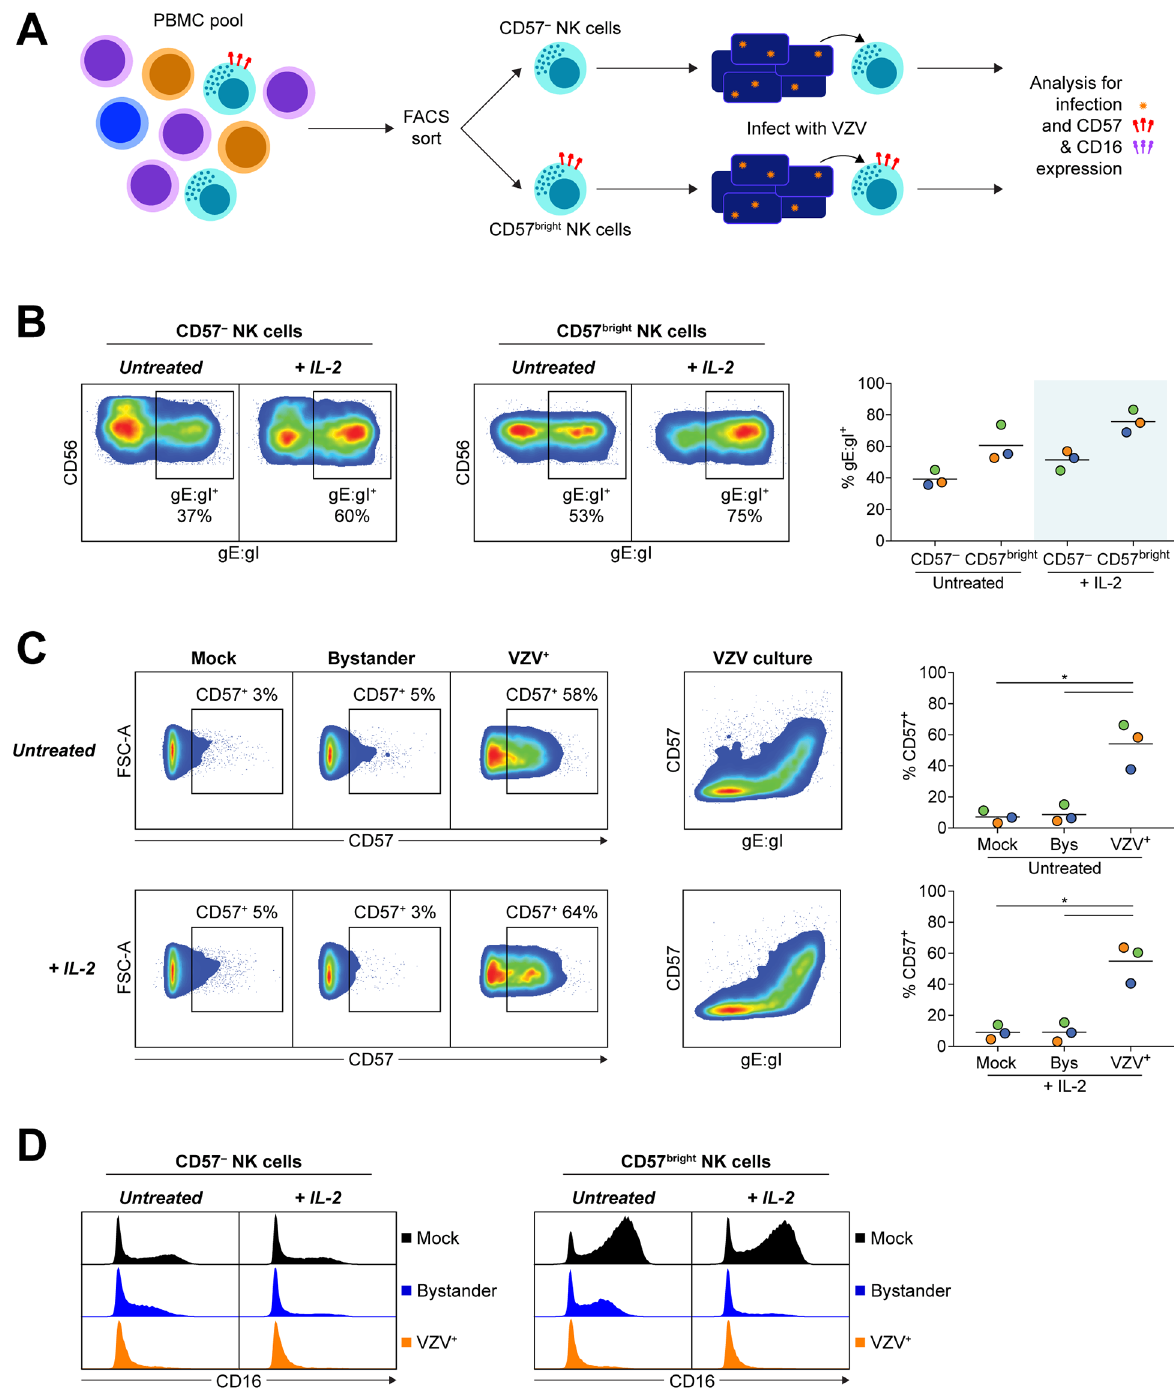
Fig 6. VZV infects both CD57 – and CD57 bright NK cells and drives CD57 expression. CD3 – CD56 + CD57 – NK cells and CD3 – CD56 + CD57 bright NK cells were isolated from healthy human donor PBMCs by FACS sorting and subsequently mock or VZV infected with or without IL-2 (200 U/ ml) for 2 days before analysis by flow cytometry. (A) Diagram describes experimental design of isolating NK cells on CD57 expression, then infecting, and subsequently analysing for infection and phenotype changes. (B) Plots show surface VZV gE:gI expression between subsets from one representative donor. Graph shows frequency of VZV + NK cell subsets when untreated or with IL-2 (shaded) for three donors. Bars indicate mean. (C) Plots show subsequent CD57 expression between mock, bystander and VZV + CD57 – NK cells (left panels) and CD57 versus gE:gI expression for VZV cultured CD57 – NK cells (middle panels), from one representative donor. Graphs show frequency of CD57 expression on mock, bystander and VZV + CD57 – NK cells for three donors. Bars indicate mean. (cid:3) p < 0.05 (two-tailed paired t test). (D) Histograms show CD16 expression for mock, bystander and VZV + CD57 – NK cells (left panel) and CD57 bright NK cells (right panel) for one representative donor (n = 3).